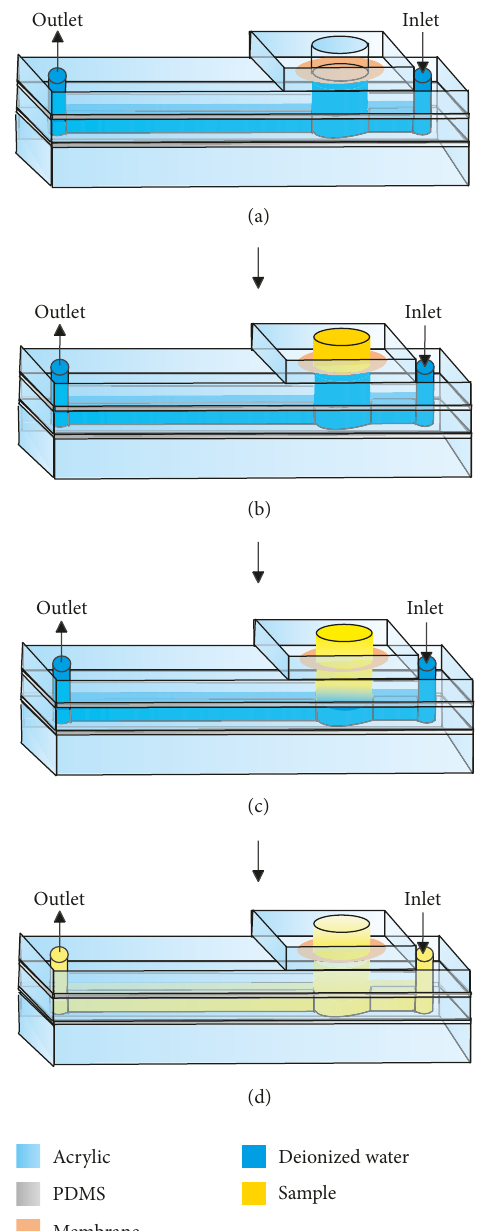
Figure 5: Illustration of diffusion microchip with the diffusion process. (a) No sample added; (b) sample added to donor; (c) sample diffusion through the membrane; (d) sample circulation in the